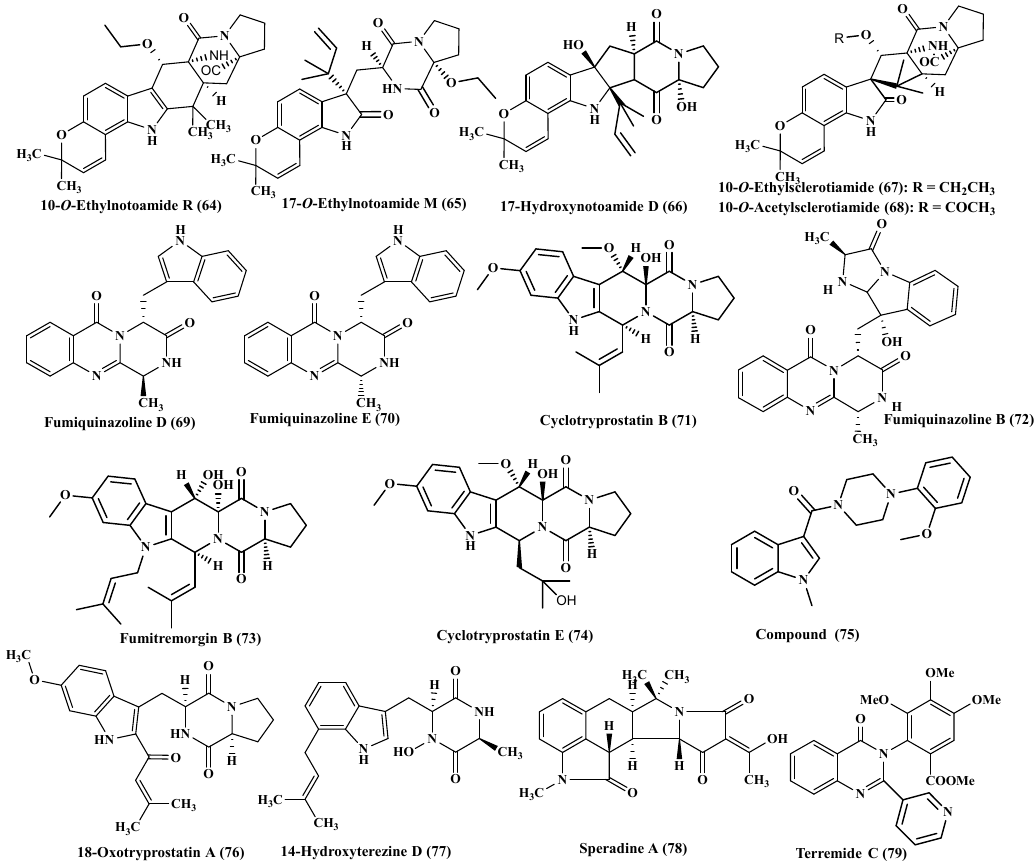
Figure 5. Alkaloids isolated from A. sulphureus , A. sydowii , A. tamari and A. terreus .